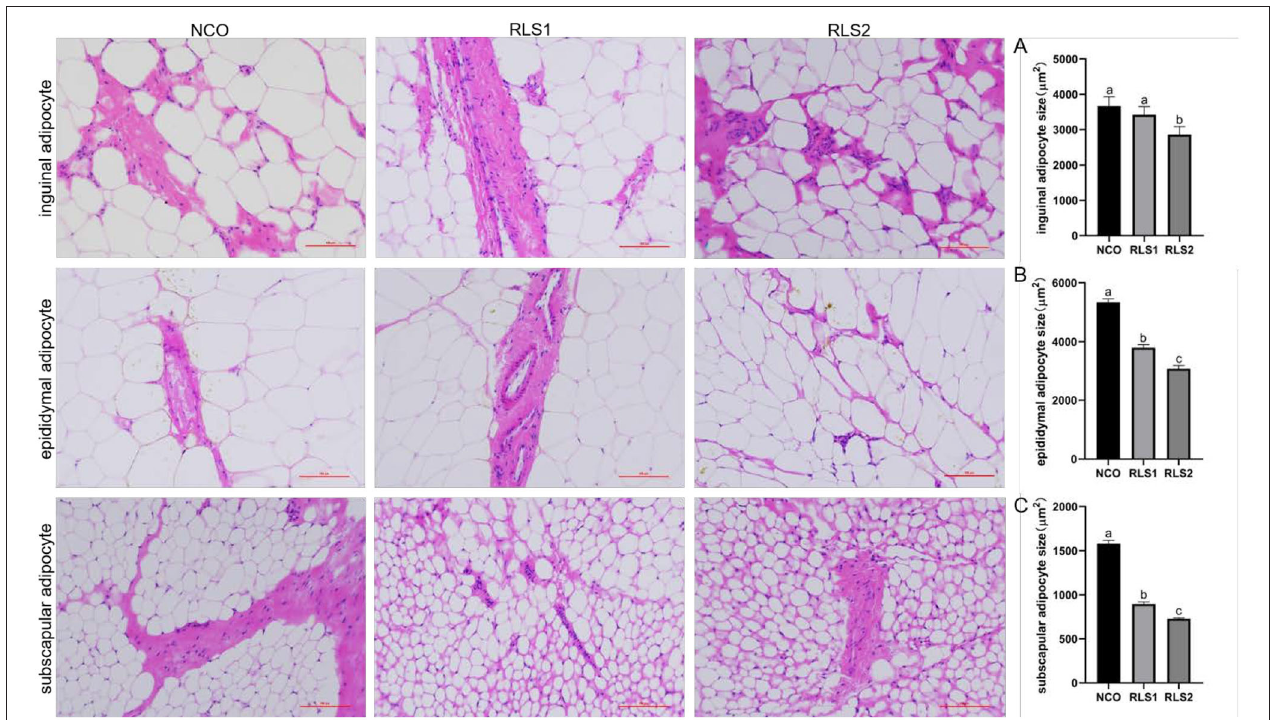
FIGURE 1 | Effects of RLS on adipocyte size in rats. NCO, rats were gavage-fed normal saline; RLS1, rats were gavage-fed 50 mg/kg · bw RLS; RLS2, rats were gavage-fed 100 mg/kg · bw RLS. HE staining (200 × ). The histograms represent quantification of the adipocyte sizes. Values are expressed as the mean ± SEM, n = 8. Different letters represent a significant difference of P < 0.05. Part labels represent standard error for the sample mean (SEM).